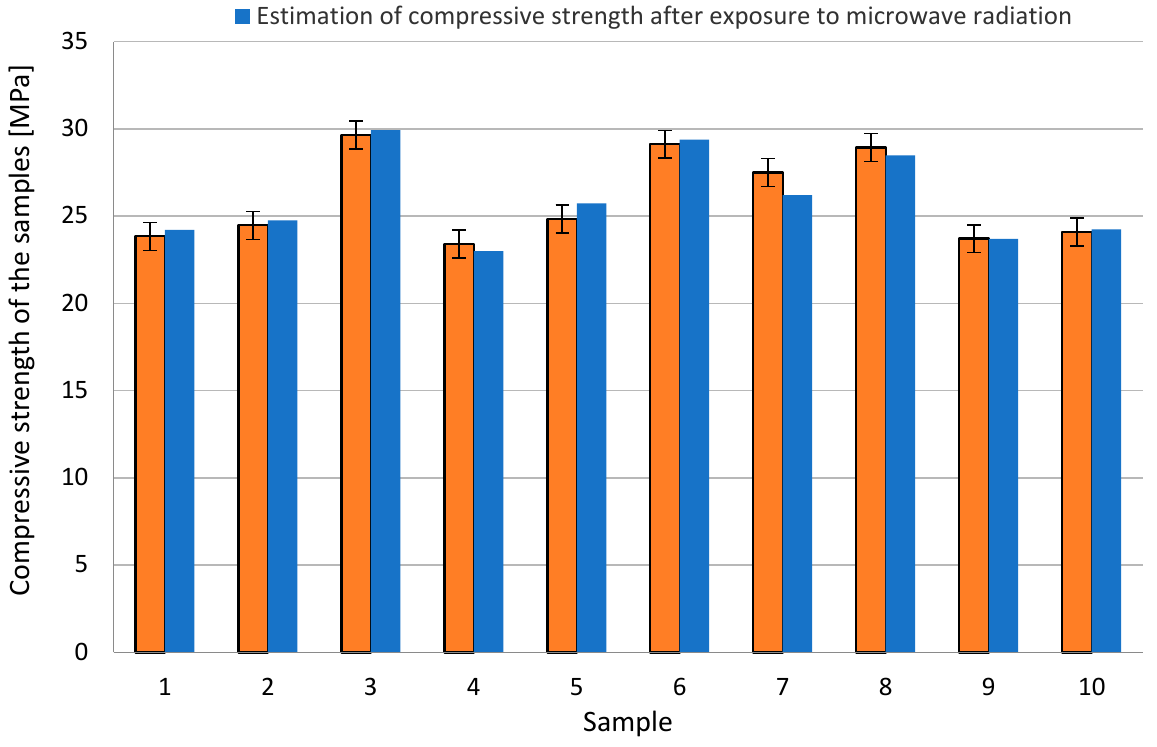
Figure 3. Overview of calculated compressive strength estimates for individual samples after drying and after exposure to microwave radiation.